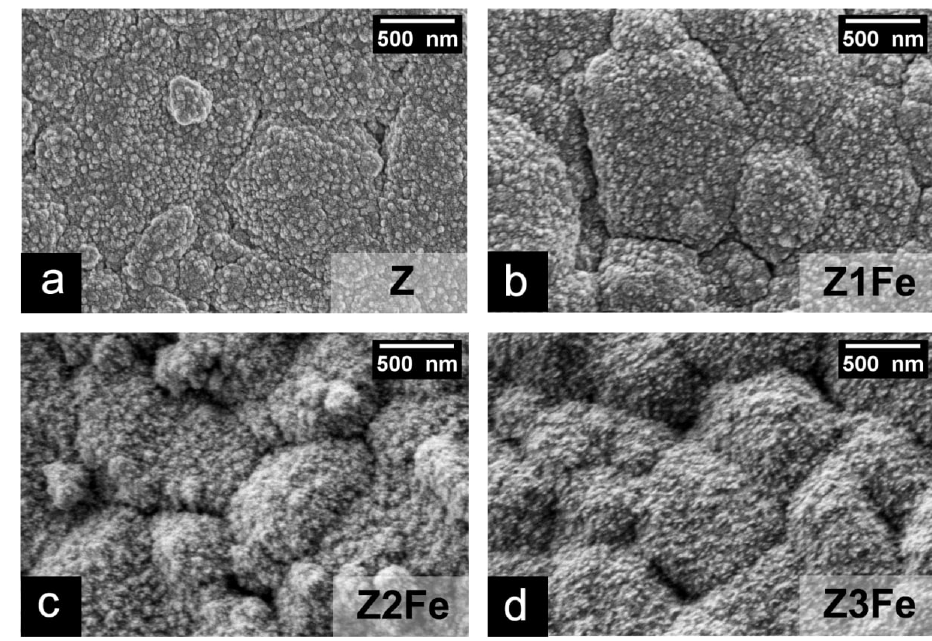
Figure 5. SEM micrographs for thin films of ZnO/Fe 2 O 3 : Z ( a ), Z1Fe ( b ), Z2Fe ( c ), and Z3Fe ( d ).